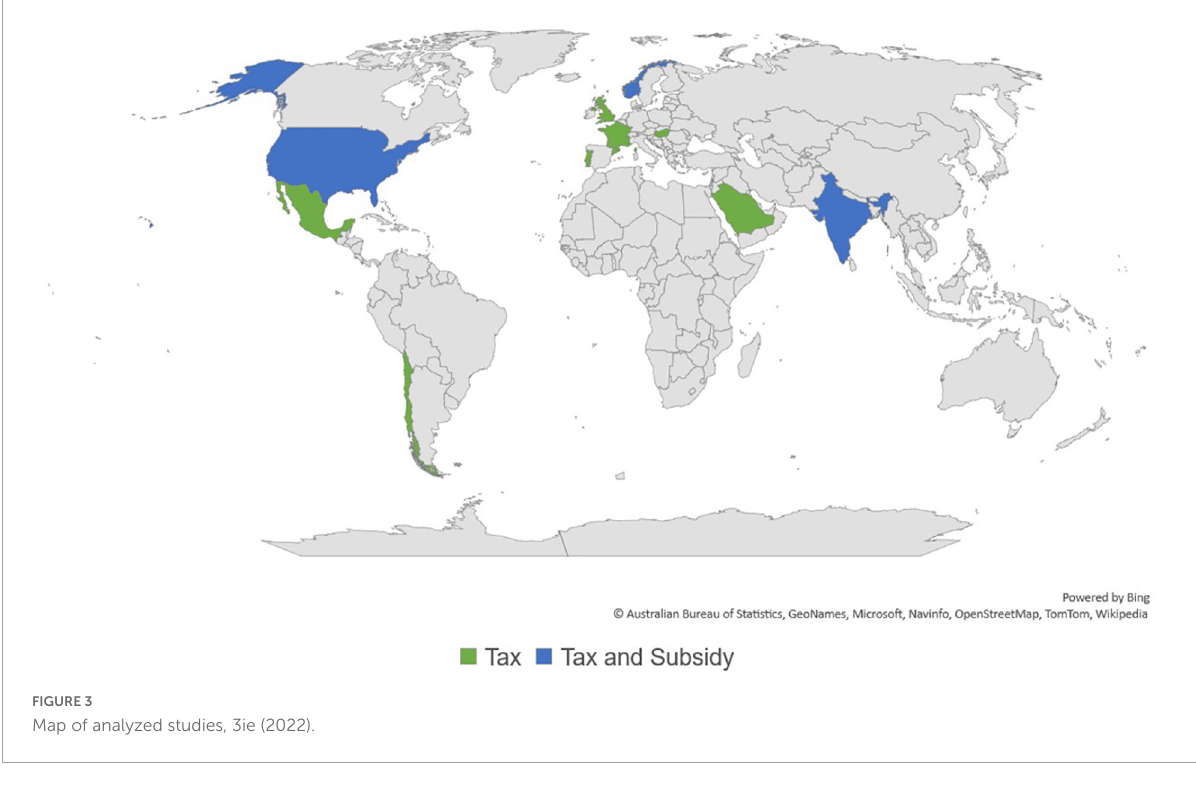
TABLE 3 Summary of included